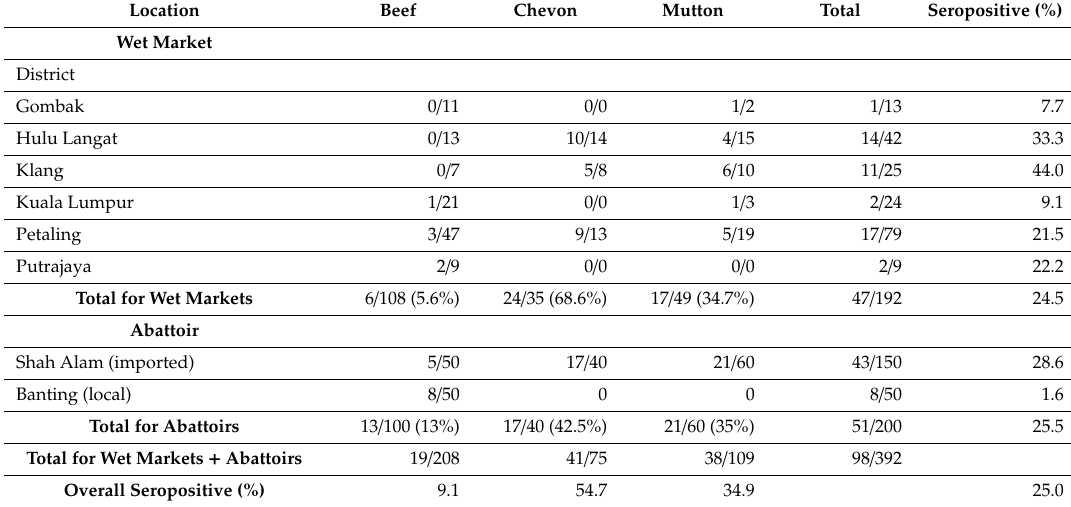
Table 3. Seropositive samples in cattle, goat and sheep purchased from wet markets in Klang Valley, and abattoirs in Selangor.